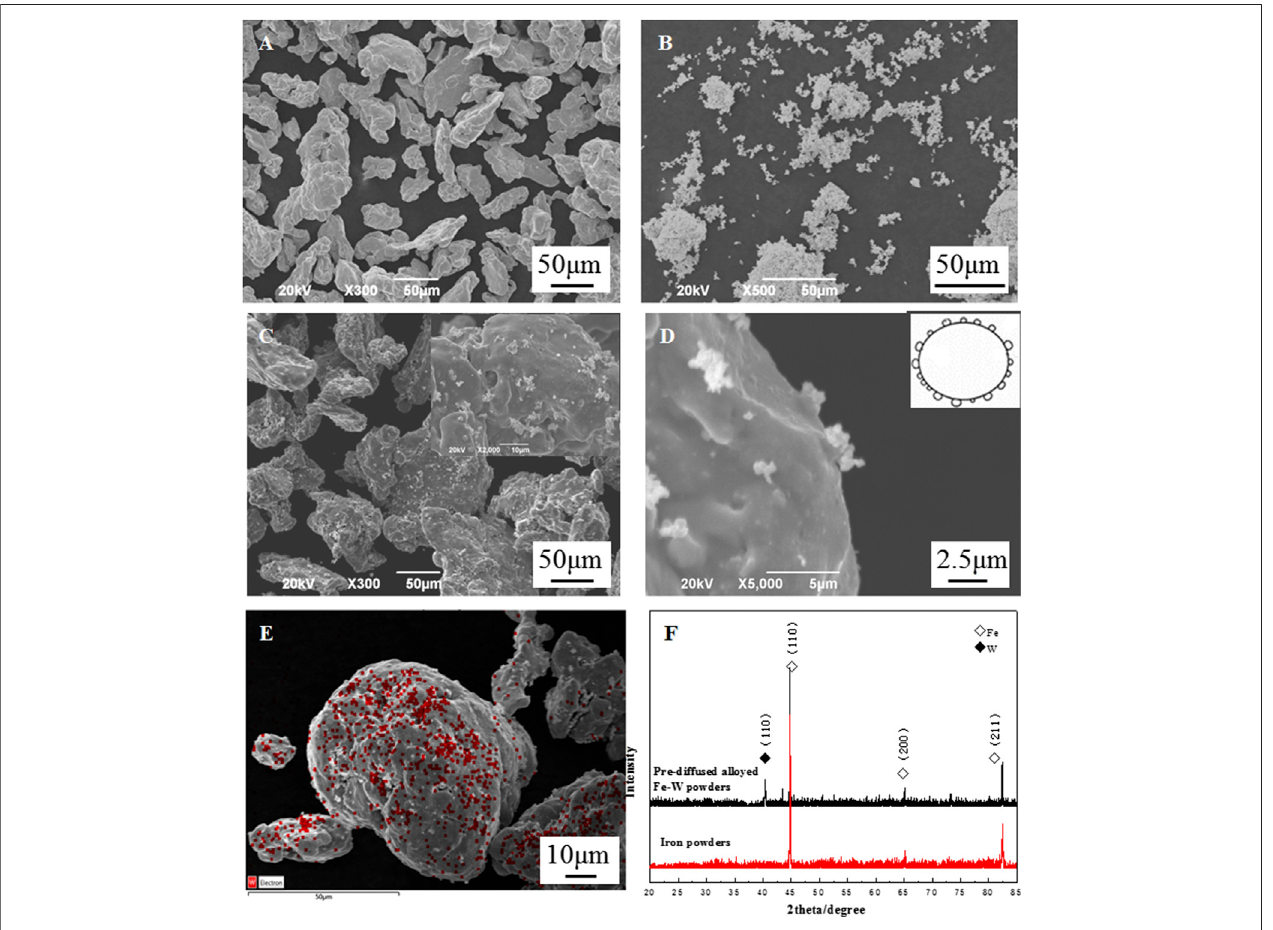
FIGURE 1 | SEM images of iron powders (A) , tungsten powders (B) and prediffused Fe-W powders (C, D) ; EDS results (E) and XRD patterns (F) of prediffused Fe-W powders.